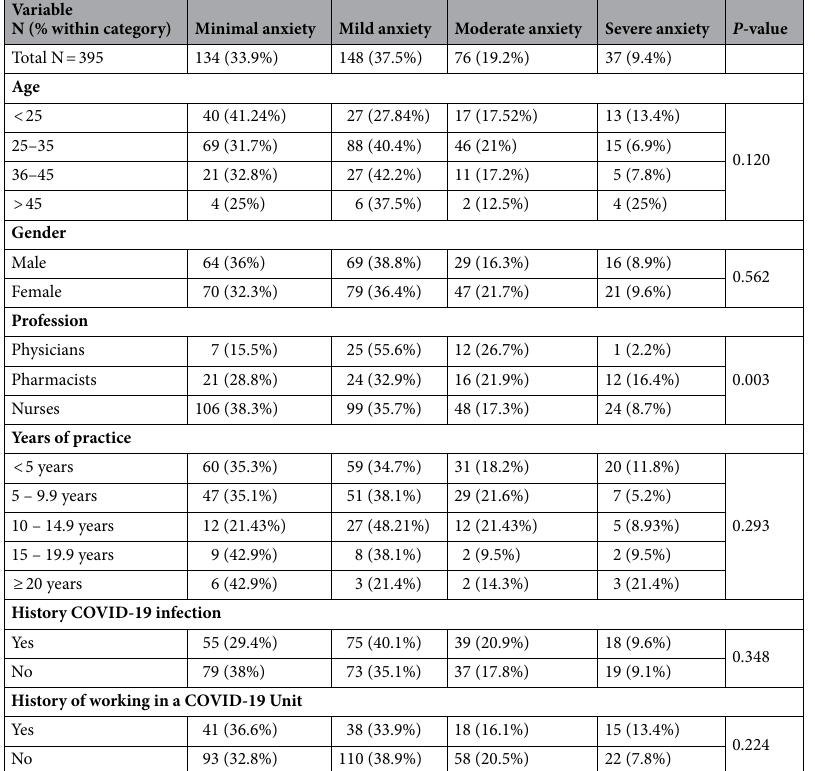
Table 2. The level of anxiety among HCWs (using GAD-7 scale).